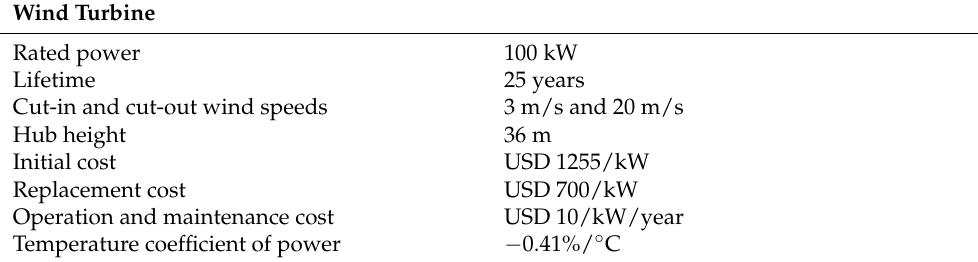
Table 3. Wind generator data.